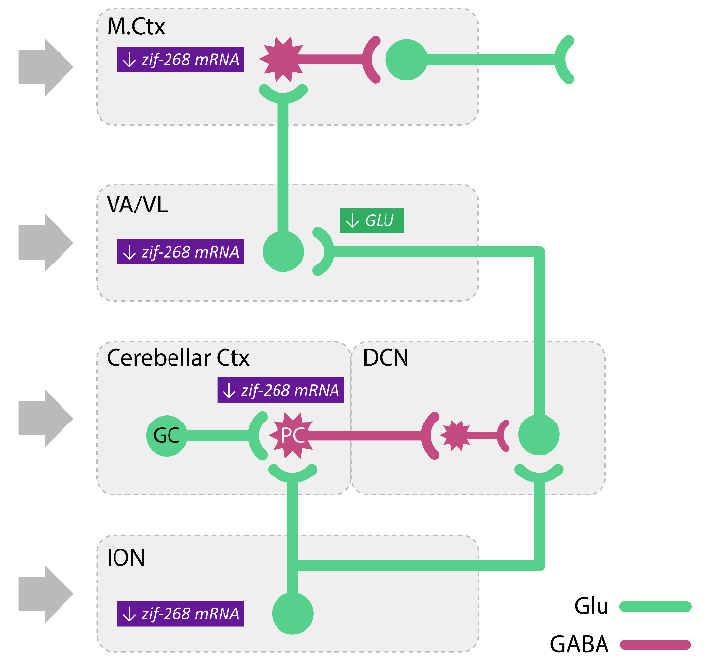
Figure 4. Scheme presenting brain structures involved in the effect of adenosine A1 agonist, 5 ′ Cl5 ′ d-(±)-ENBA, on the harmaline-increased zif-268 mRNA expression as well as on the harmaline-enhanced glutamate release in the VA/VL nuclei of the thalamus. Grey arrows indicate areas of the brain potentially involved in the tremorolytic effect of 5 ′ Cl5 ′ d-(±)-ENBA, where effects on general neuronal activity and glutamate transmission have been observed (based on research [118,129]). DCN: deep cerebellar nuclei, GC: granular cell, ION: inferior olive nuclei, M.Ctx: motor cortex, PC: Purkinje cell, VA/VL: ventroanterior/ventrolateral thalamic nuclei. For additional information, see Section 4.4.